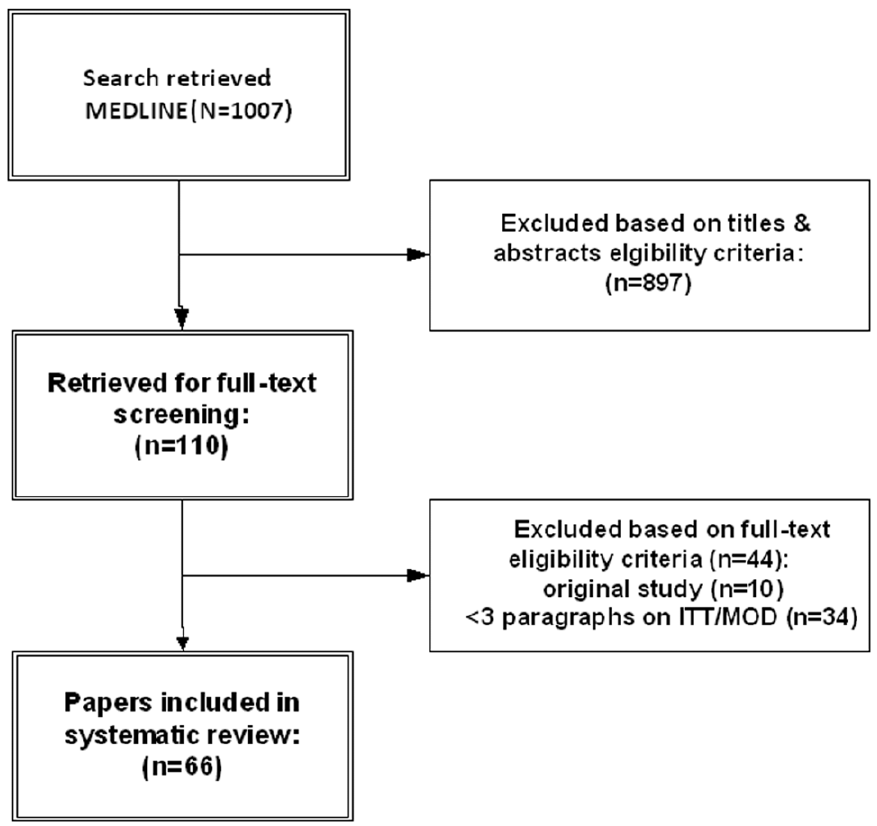
Figure 1. Flow diagram for articles included in this review. ITT, intention to treat; MOD, missing outcome data.